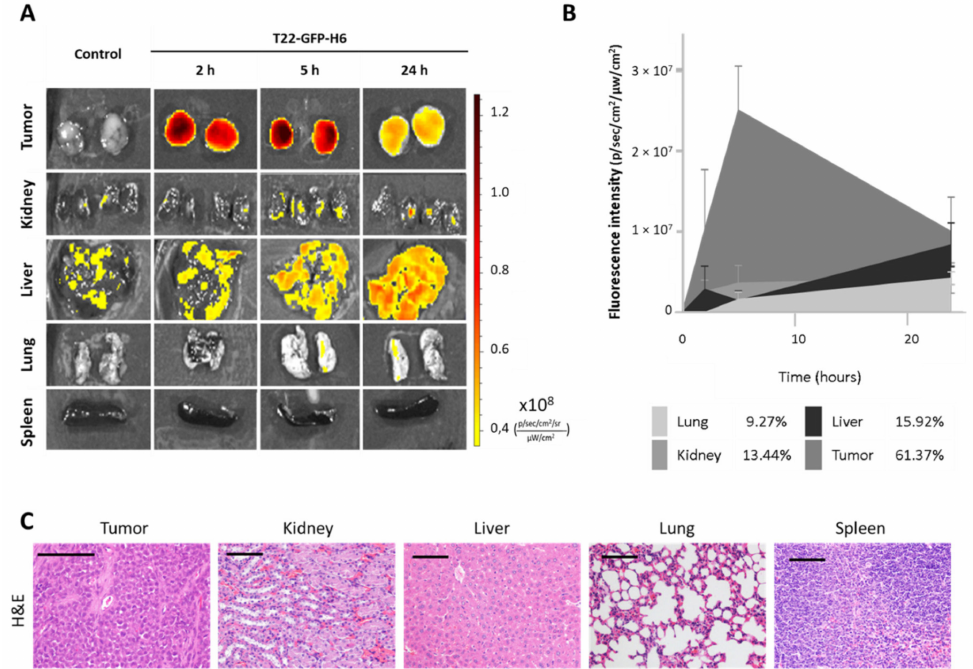
Figure 5. In vivo biodistribution and toxicity assessment of nanocarrier T22-GFP-H6 in a subcuta- neous mouse model derived from CXCR4+ AN3CA cells. ( A ) Representative images of fluorescence emitted by the nanocarrier after 2, 5 and 24 h after intravenous injection of 200 µ g of T22-GFP-H6. ( B ) Area under the curve representation of fluorescence emitted over time by tumor and non-tumor tissues, and their respective percentage of nanocarrier uptake out of the total fluorescence emitted by T22-GFP-H6 in all tissues ( n = 4/group; mean ± s.e.m). ( C ) Hematoxylin-eosin staining of tumor and non-tumor organs 48 h after administration of the nanocarrier. Bar: 100 µ